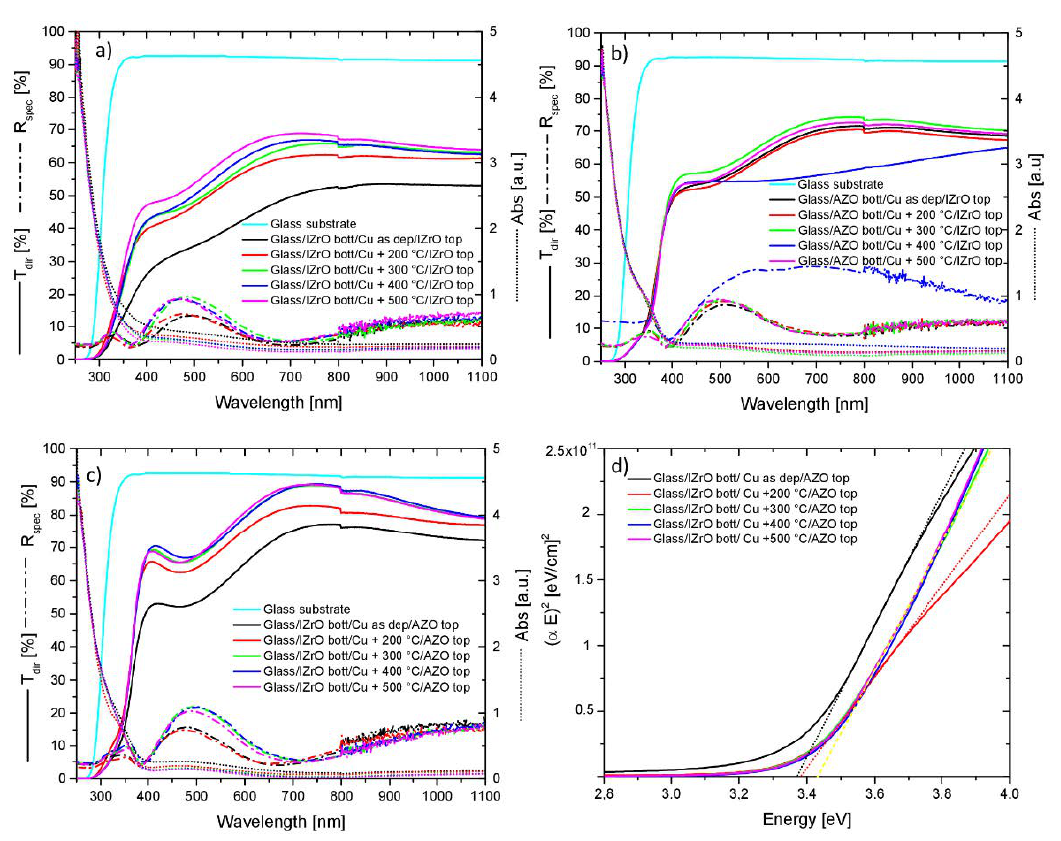
Figure 4. Transmittance, reflectance, and absorbance curves of dry PCS as a function of the anneal- ing temperature with all combinations of AZO and IZrO layers as the top and bottom TCO: ( a ) IZrO bott /Cu/IZrO top ; ( b ) AZO bott /Cu/IZrO top ; ( c ) IZrO bott /Cu/AZO top . The transmittance of the bare glass substrate is reported as a reference. ( d ) Tauc plots and calculated linear fit of the samples re- ported in ( c ).